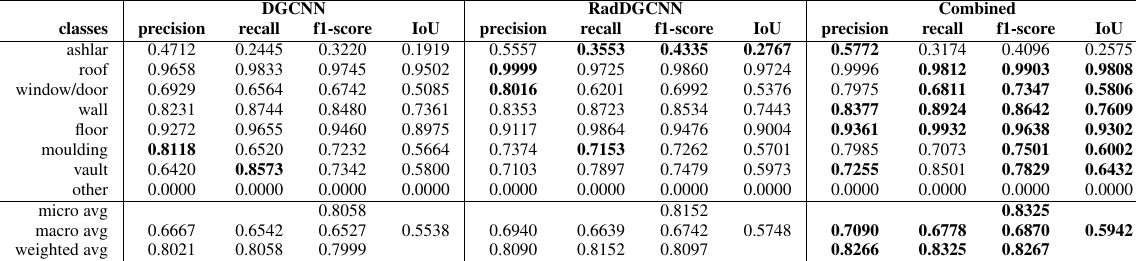
Table 4. Results of the semantic segmentation of the Palazzo Ferretti